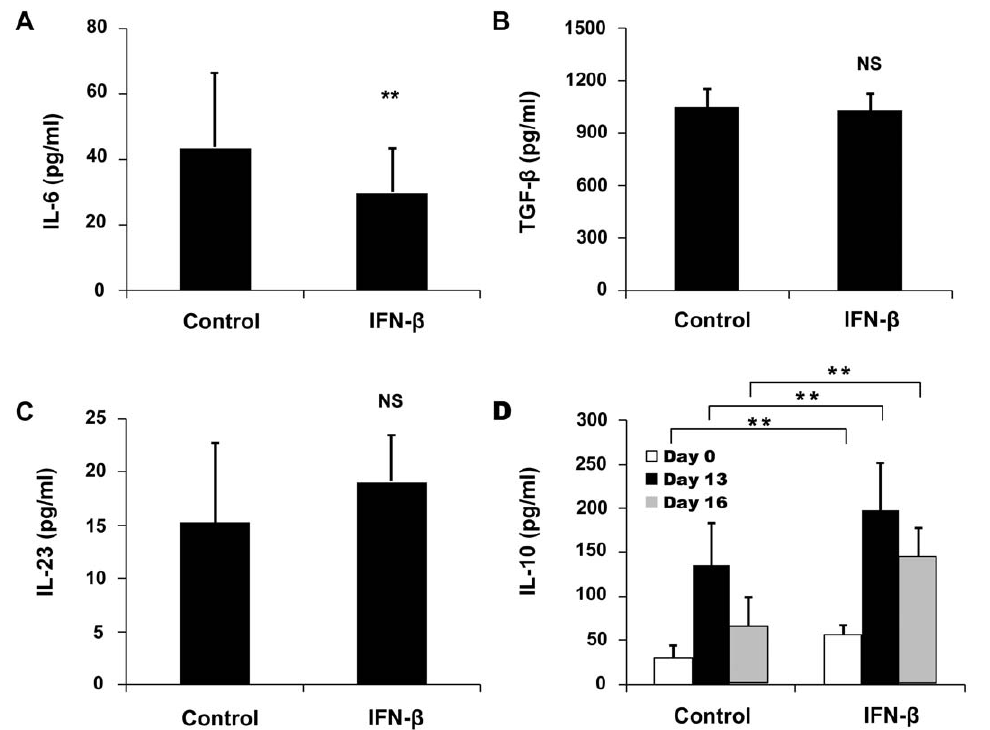
Figure 7. Effect of IFN- b on IL-6, TGF- b , IL-23 and IL-10 production by monocytes. Monocytes from immunized mice on day 13 (or on day 0 and day 16 where indicated), cultured with or without IFN- b (250 U/ml) for 24 hours, were stimulated with LPS (100 ng/ml) for another 24 hours. Cytokines were detected by ELISA. Data are representative of three independent experiments. **p , 0.01, NS=not significant.